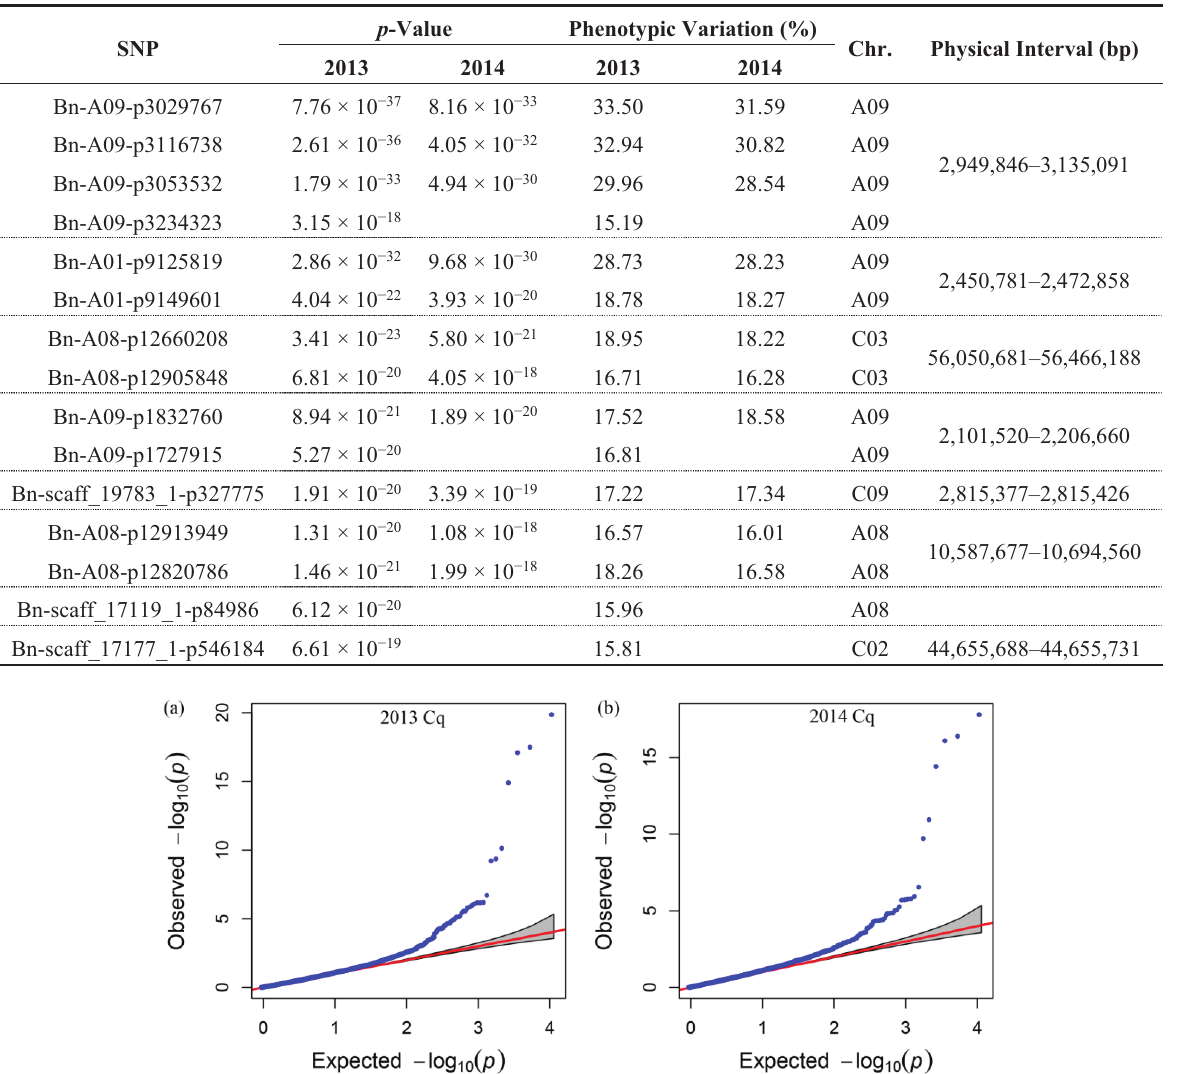
Table 3. Genome-wide significant association signals of seed glucosinolate content.